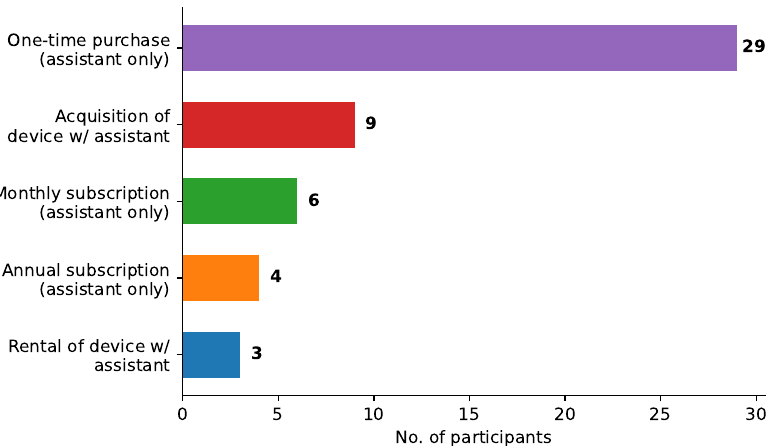
Figure 8. Results for the question concerning the preference for the acquisition of our